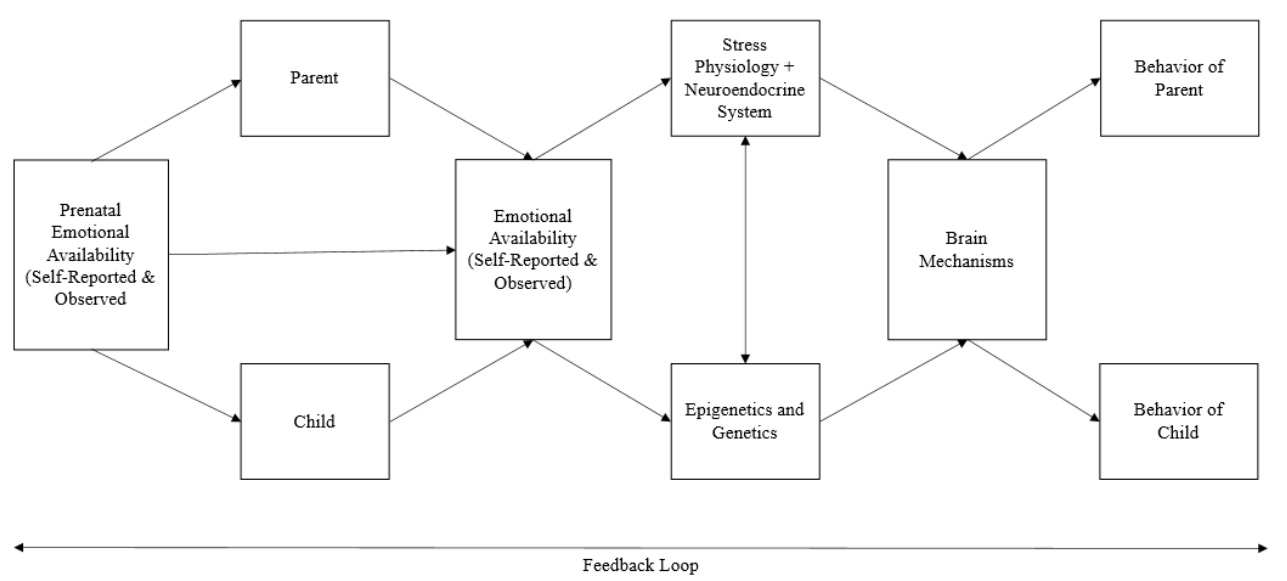
Figure 2. Emotional availability theoretical model.